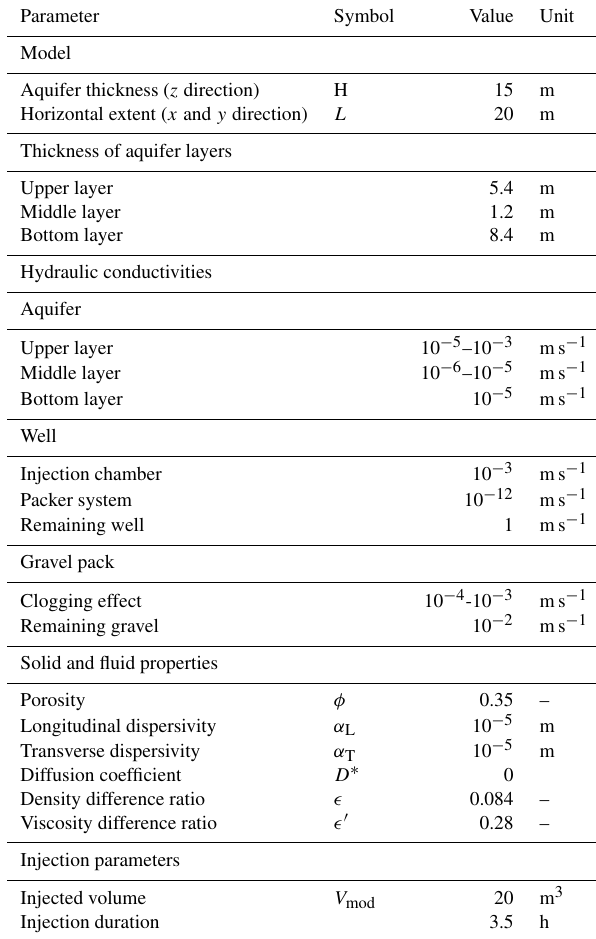
Table 1. Flow and transport input parameters for the different zones in the